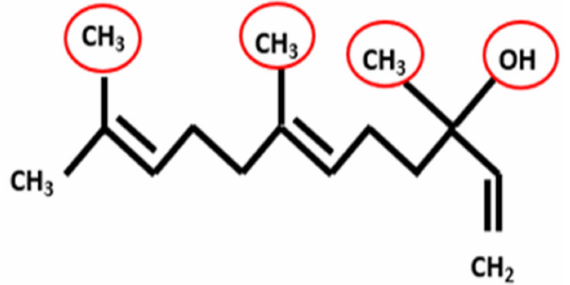
Figure 1. The chemical structure and the functional groups of